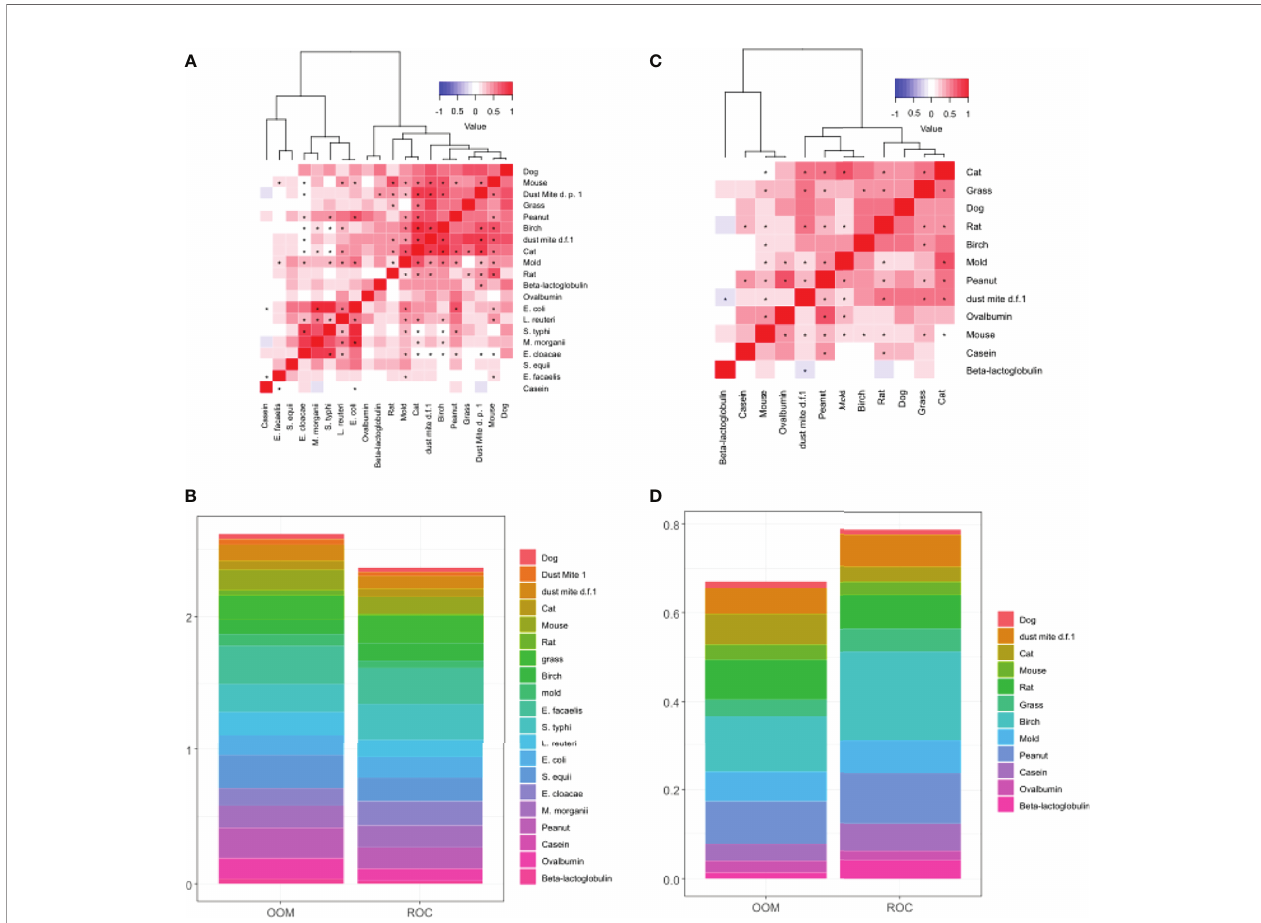
FIGURE 3 | Characterization of IgA 1 and IgA 2 responses in human milk. Hierachial clustering of IgA 1 levels depicting correlation between antigen-speci fi c IgA1 (A) and IgA2 levels (C) . (B) Stacked bar plot of IgA 1 levels normalized between 0 and 1 depicting higher accumulated levels of IgA 1 in OOM. (D) Stacked bar plot of IgA 2 levels normalized between 0 and 1 depicting higher accumulated levels of IgA 2 in Rochester. IgA2 levels to bacteria antigens were too low to graph. D.p., Dermatophagoides pteronyssinus ; d.f, Dermatophagoides farina . * indicates statistically signi fi cant correlation with